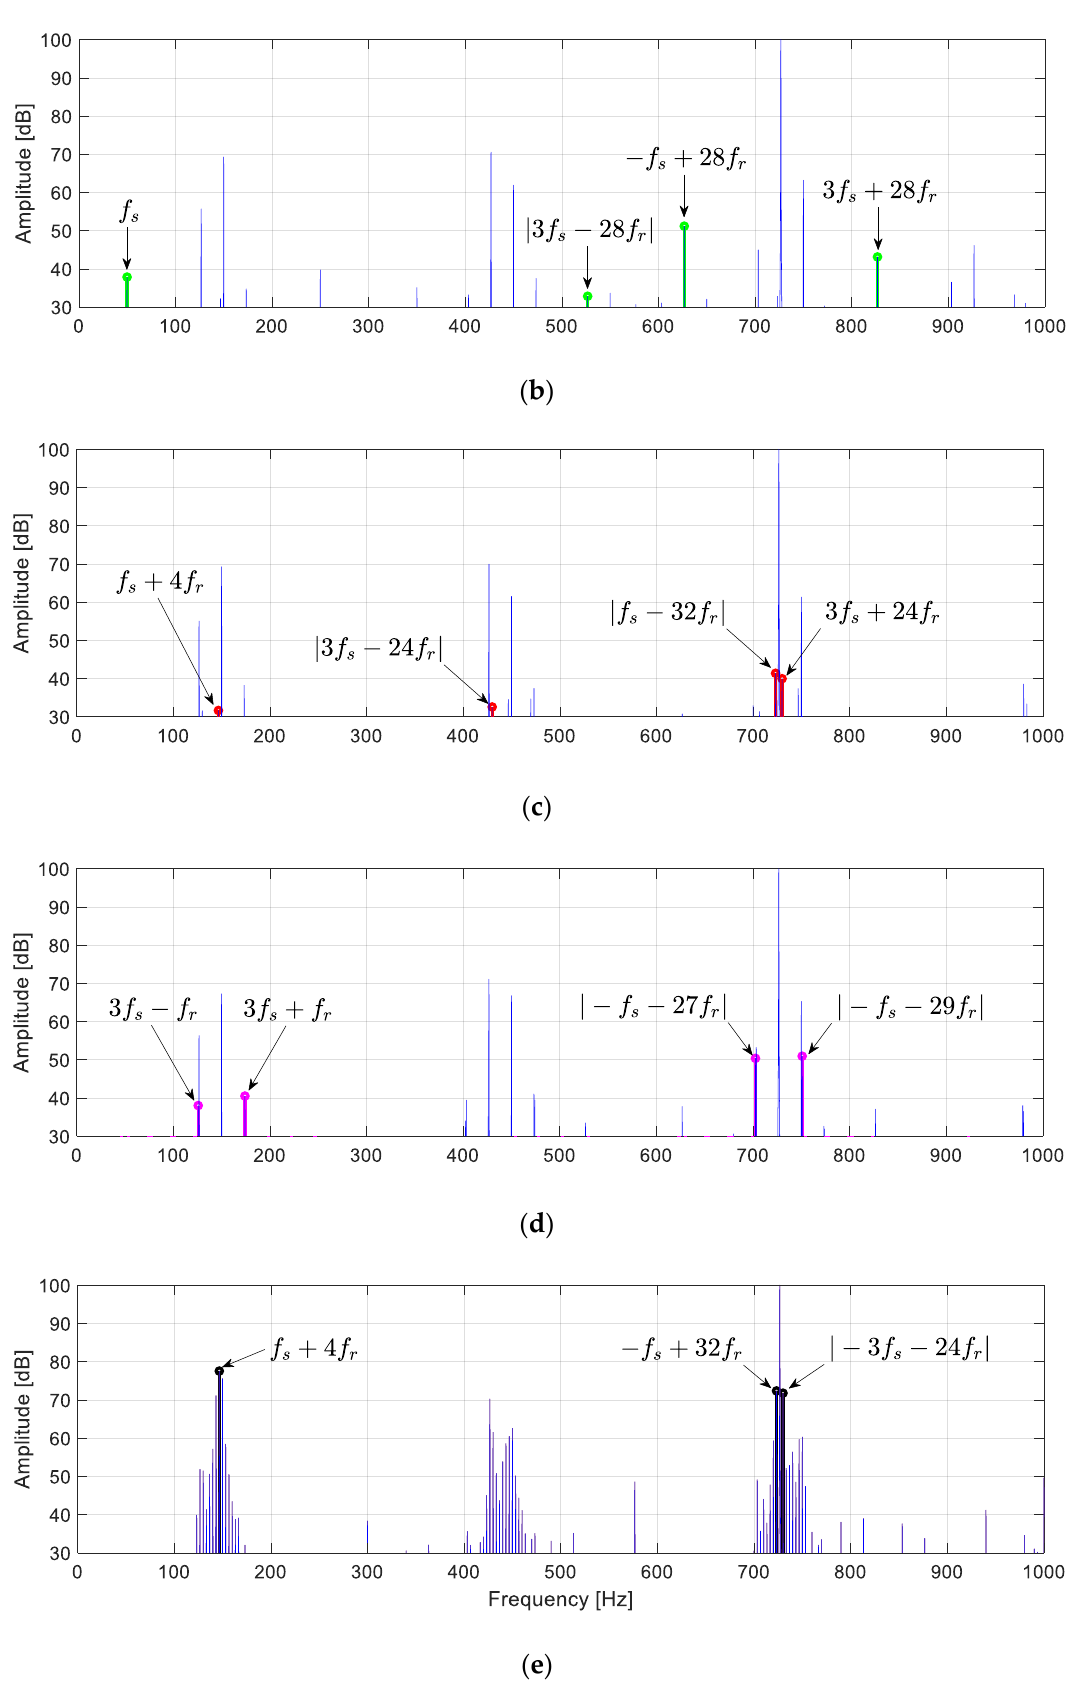
Figure 11. ZSV spectra for the following cases: ( a ) symmetry, ( b ) static eccentricity, ( c ) dynamic eccentricity, ( d ) mixed eccentricity, and ( e ) damaged rotor cage.